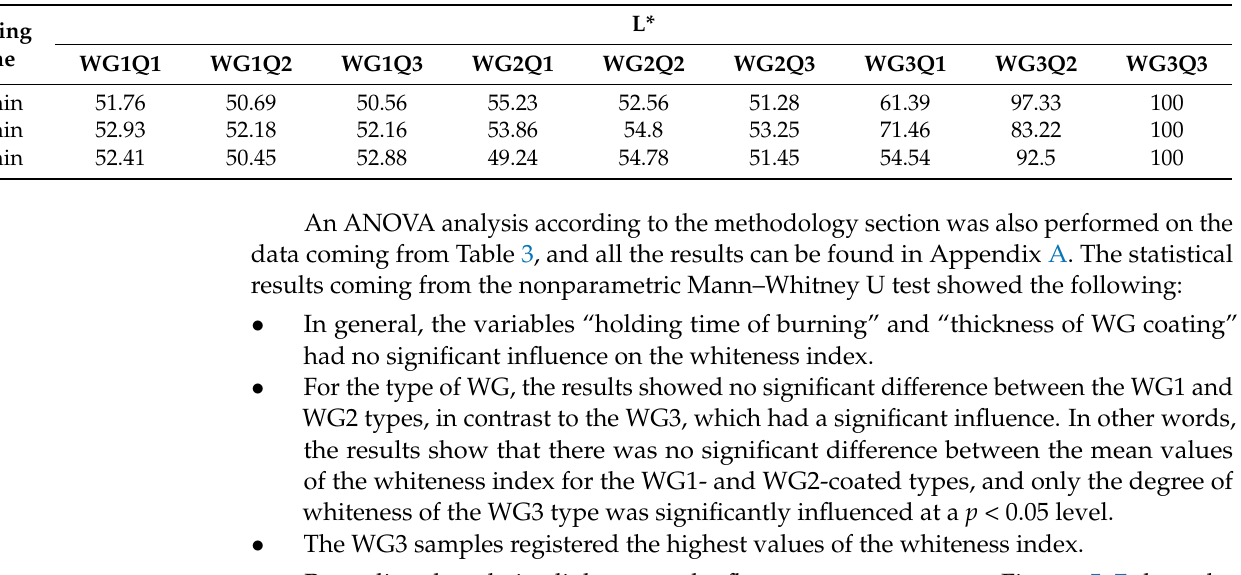
Table 3. Degree of whiteness (L*) of the 27 WG-coated tile